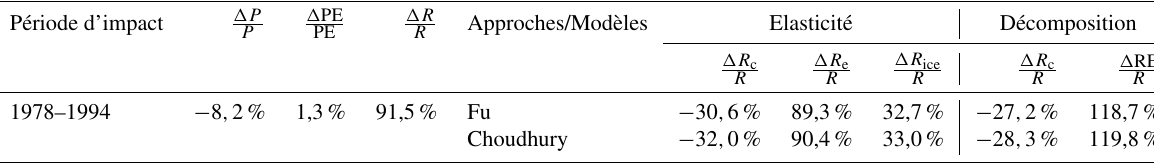
Tableau 1. Impacts du climat et de l’environnement sur les écoulements du Nakanbé à Wayen. Période d’impact Approches/Modèles Elasticité